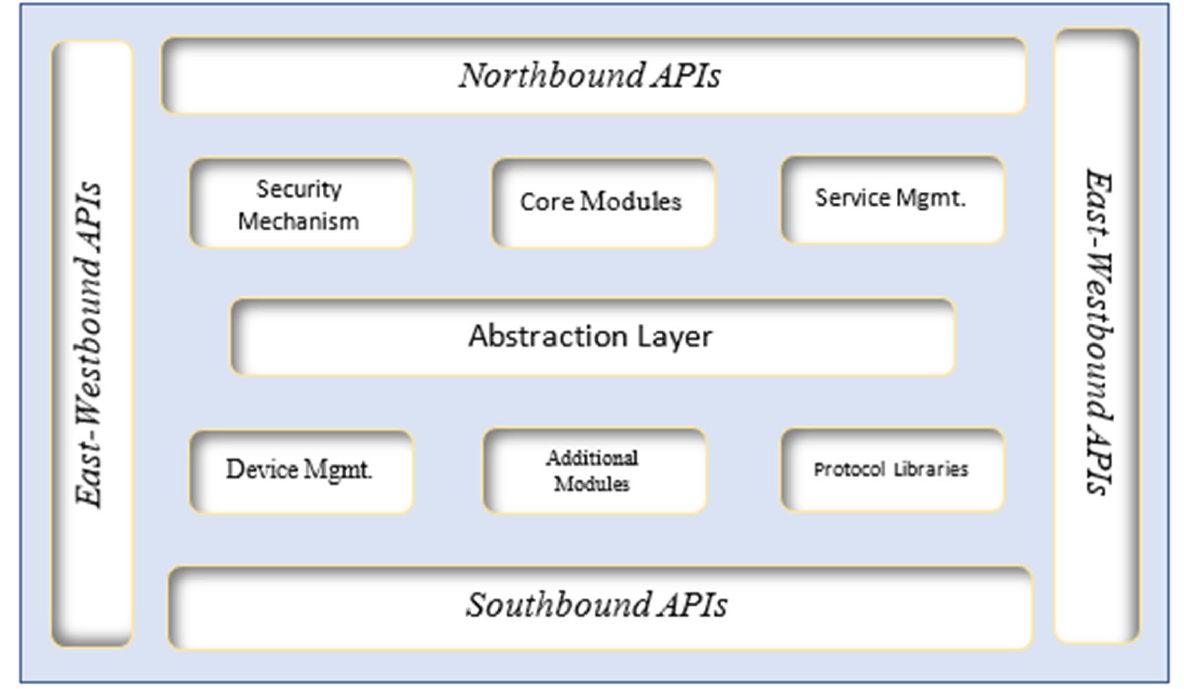
Figure 8. SDN controller architecture.